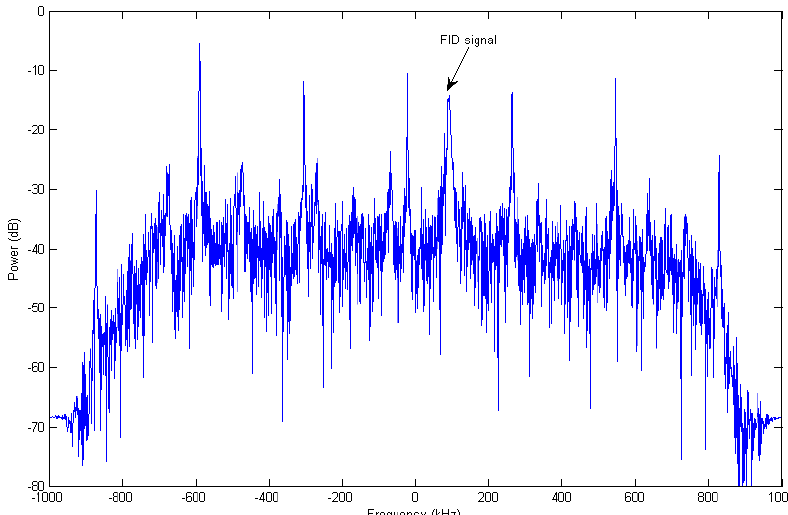
Figure 4. Spectrum of one FID data set of a low SIR. The data has been pre-processed (demodulation, low pass filtering and extraction). The FID signal peak is marked; others are RFI peaks. Obviously, the spectral width of the FID signal is broader than that of RFI.